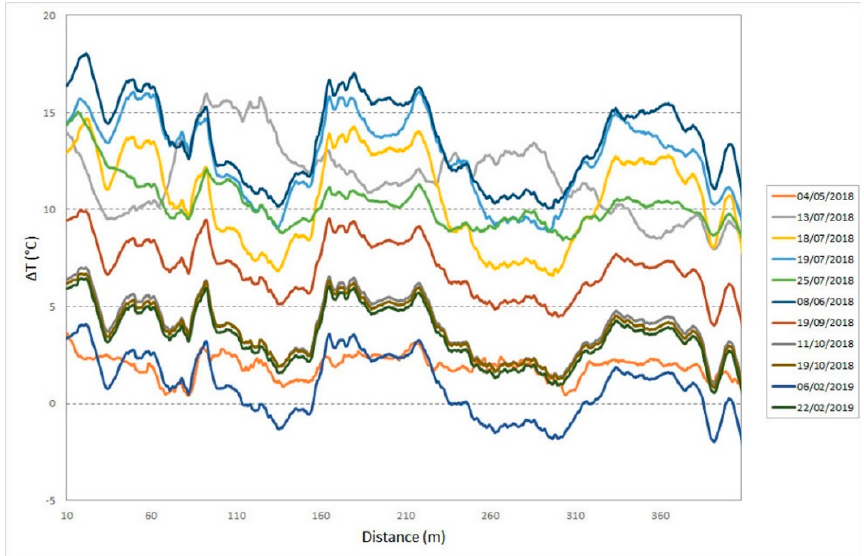
Figure 22. DOFS temperature variation profiles along the marble buttress from January 2018 to February 2019.